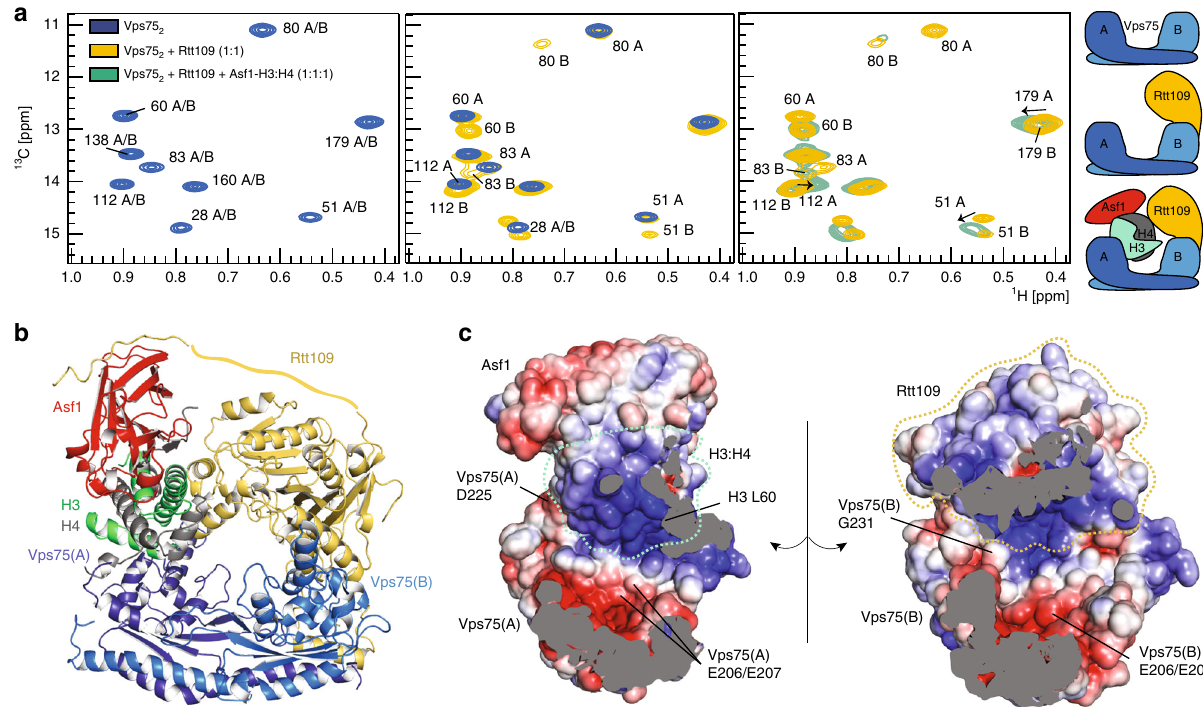
Fig. 1 Vps75 2 forms a doughnut-shaped complex with Asf1, H3:H4 and Rtt109. a Overlay of 1 H- 13 C HMQC spectra of ILV methyl-labeled Vps75 2 in isolation, with Rtt109 and in the Asf1 – H3:H4 – Rtt109 – Vps75 2 complex. In Vps75 2 , Vps75(A) and Vps75(B) have identical chemical shifts (left). In complex with Rtt109 (middle), only Vps75(B) displays CSPs. Upon further addition of Asf1 – H3:H4 (right), the Vps75(B) peaks do not shift further, while Vps75(A) displays noticeable CSPs. Thus, Vps75(B) recruits Rtt109, while Vps75(A) binds Asf1 – H3:H4. Spectra were recorded on samples of 60 μ M Vps75 2 in 50 mM sodium citrate pH 6.5, 150 mM NaCl, 5 mM BME at 850 MHz and 298 K. b The Asf1 – H3:H4 – Rtt109 – Vps75 2 complex adopts a doughnut-like shape with a central cavity of ~25 Å width. The Rtt109 C-terminal tail (Rtt109 419 – 433 ) is shown bound to Asf1, as described in Lercher et al. 34 (PDB entry 6f0y). A fl at ribbon indicates the portion of the Rtt109 C-terminal tail for which no structural information is available. The disordered Vps75 and H3 tails are not shown. c Electrostatic surface representation of the inner part of the complex. D225 and G231 are the last structured amino acids of Vps75 2 ; L60 is the fi rst amino acid of the H3 core; the Vps75- 206 EE 207 dyad is at the center of an acidic